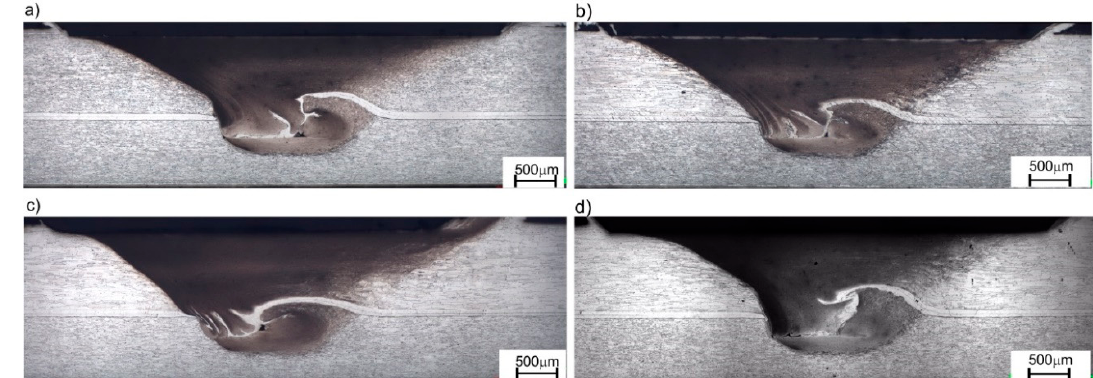
Figure 11. Cross-section of FSW joints welded: ( a ) FSW joint made with a new tool made of 1.2344 steel, ( b ) FSW joint made with a new AlCrN-coated tool (1.2344), ( c ) FSW joint made with a worn-out tool (1.2344)—total length of FSW joint: 200 m, ( d ) FSW joint made with an AlCrN-coated worn-out tool (1.2344)—total length of FSW joint: 200 m.